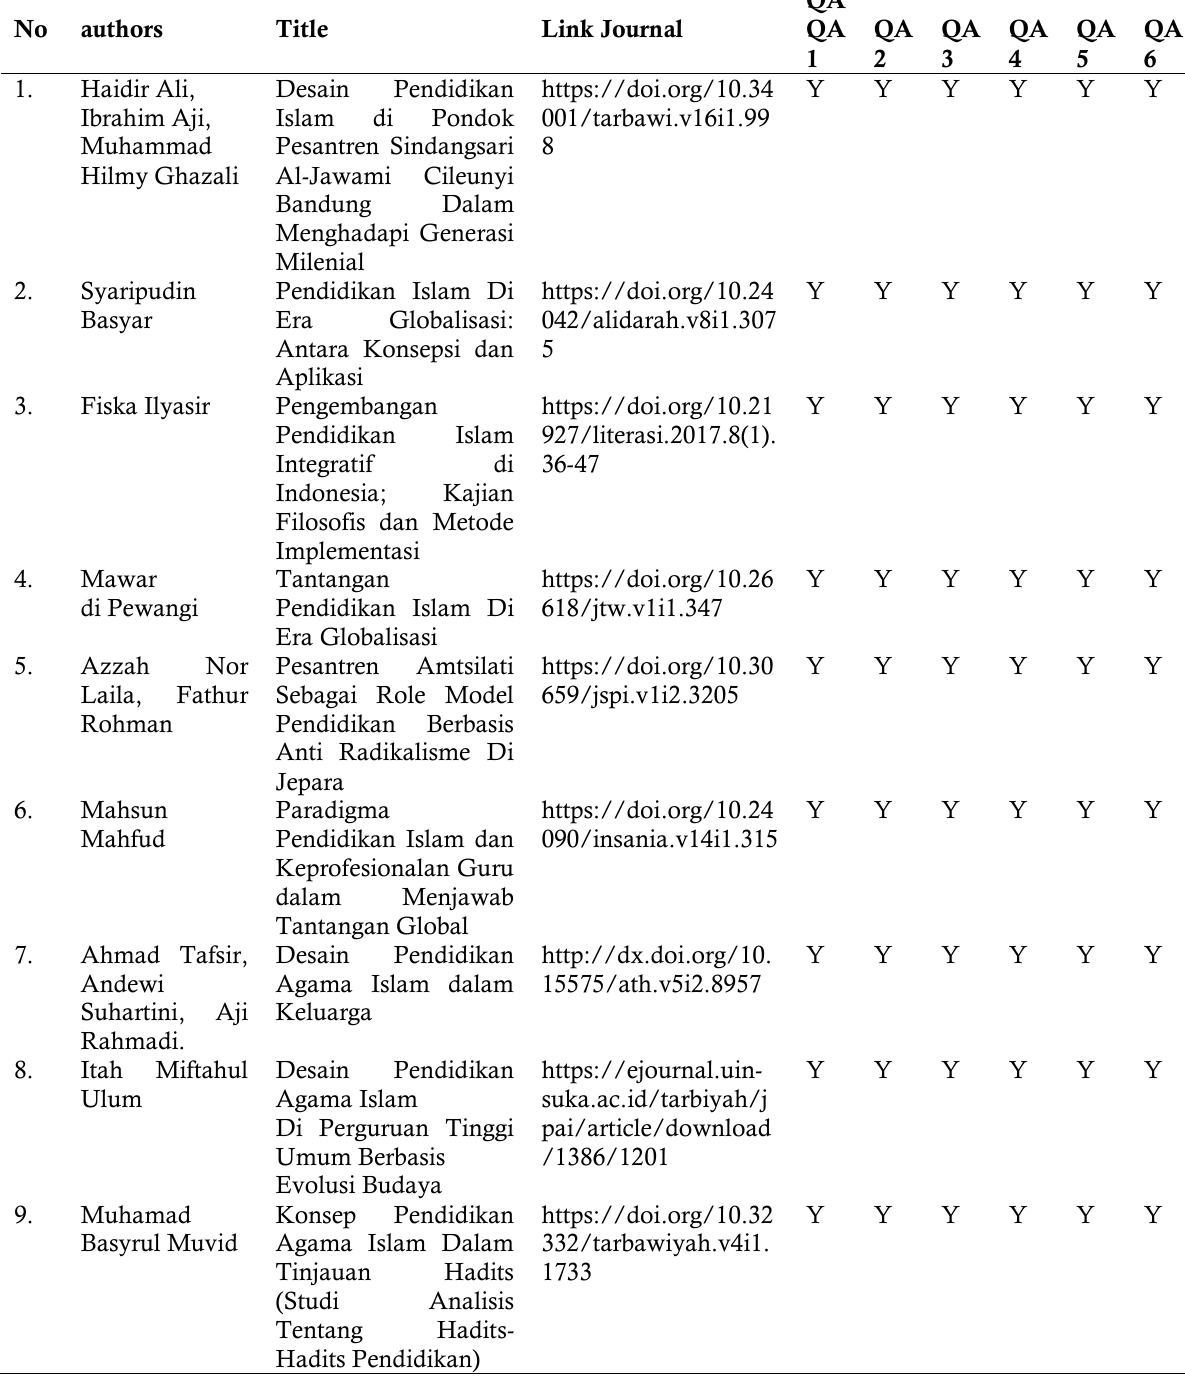
Table 3 <Kualifikasi Artikel